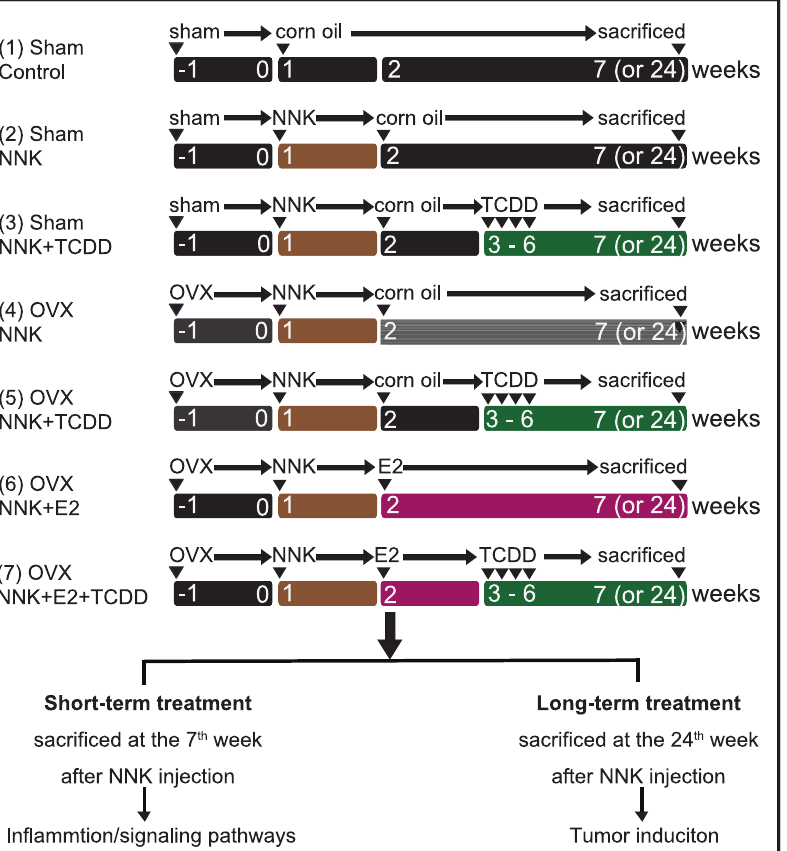
Figure 1. Experimental design. Female A/J mice were divided into 7 groups in which groups 1–3 were sham-operated (Sham) and groups 4–7 were ovariectomized (OVX). Mice were OVX 2 weeks before given NNK. Group 1 is the sham-operated control group in which mice were given corn oil i.p. 3 times per week until the end of the experiment. Groups 2–7 were pretreated with NNK (1 mg/0.1 ml/mouse, i.p.) at the 1 st week of the experiment. Groups 3, 5, and 7 received a loading a dose of TCDD (5 m g kg/b.w./i.p.) from week 3 and the maintaining dose of TCDD (1.42 m g kg/ b.w./i.p) 3 times weekly from week 4 for 3 weeks. In week 2, groups 6 and 7 were exposed to 17 b -estradiol (E2, 2 m g/kg/b.w.) subcutaneously every 2 days continuously until the end of the experiments. The experiments were terminated after the 7 th week as a short-term exposure model to